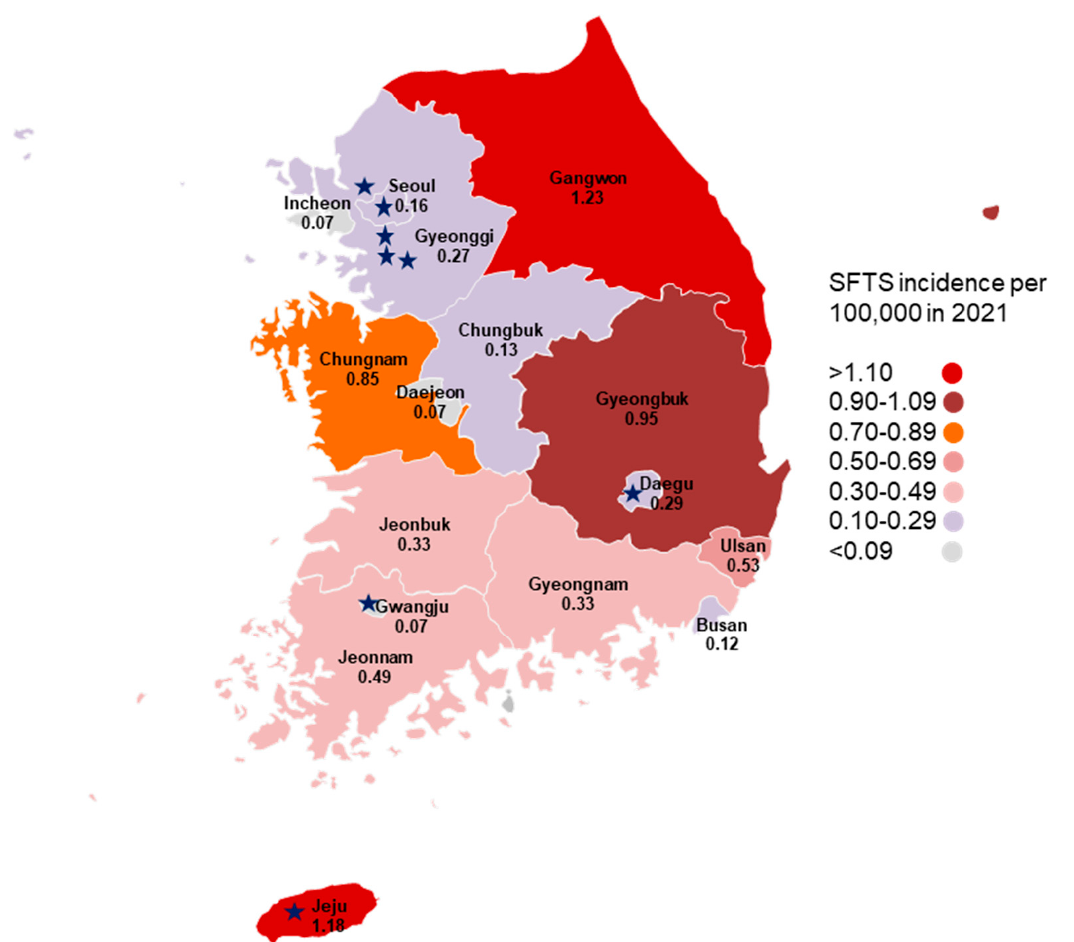
Figure 1. A choropleth map showing the incidence of SFTS per 100,000 population according to each region in 2021 and the participating veterinary hospitals’ locations ( ★ ). SFTS, severe fever with thrombocytopenia syndrome.